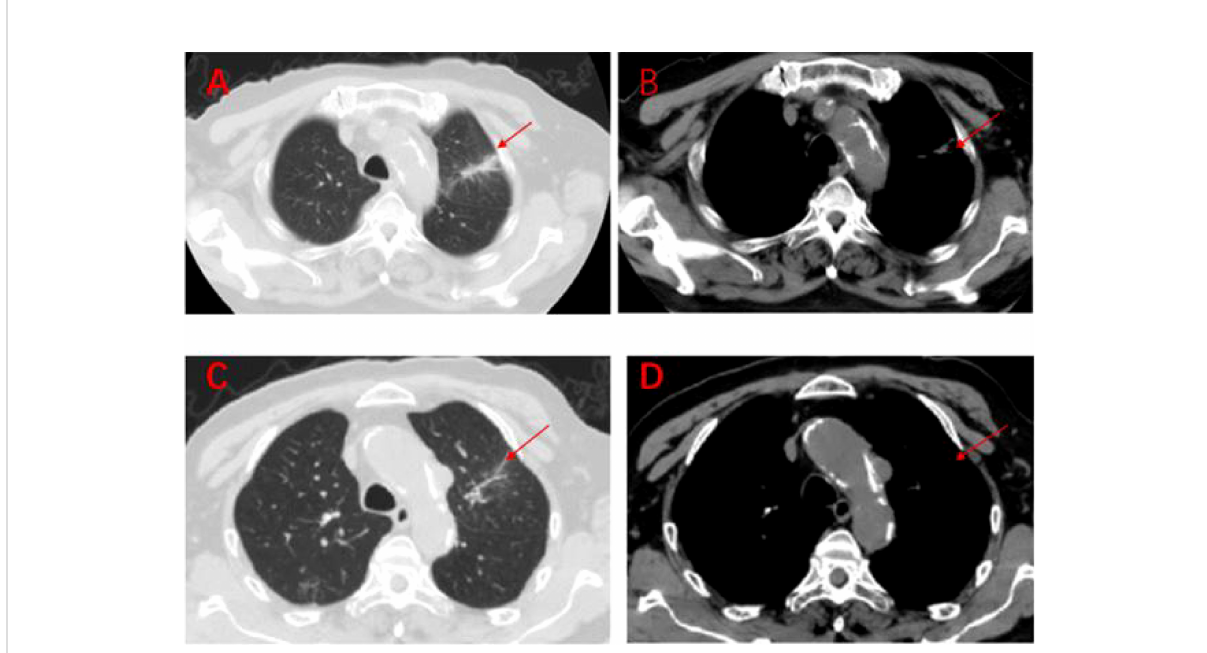
FIGURE 7 Regular imaging at follow-up, tumour lesions continue to shrink, ef fi cacy maintained at PR (A – D) . (A, B) : On 7 March 2020, a lung CT scan revealed almost no tumour lesions. (C, D) : On 3 October 2020, a lung CT scan revealed almost no tumour